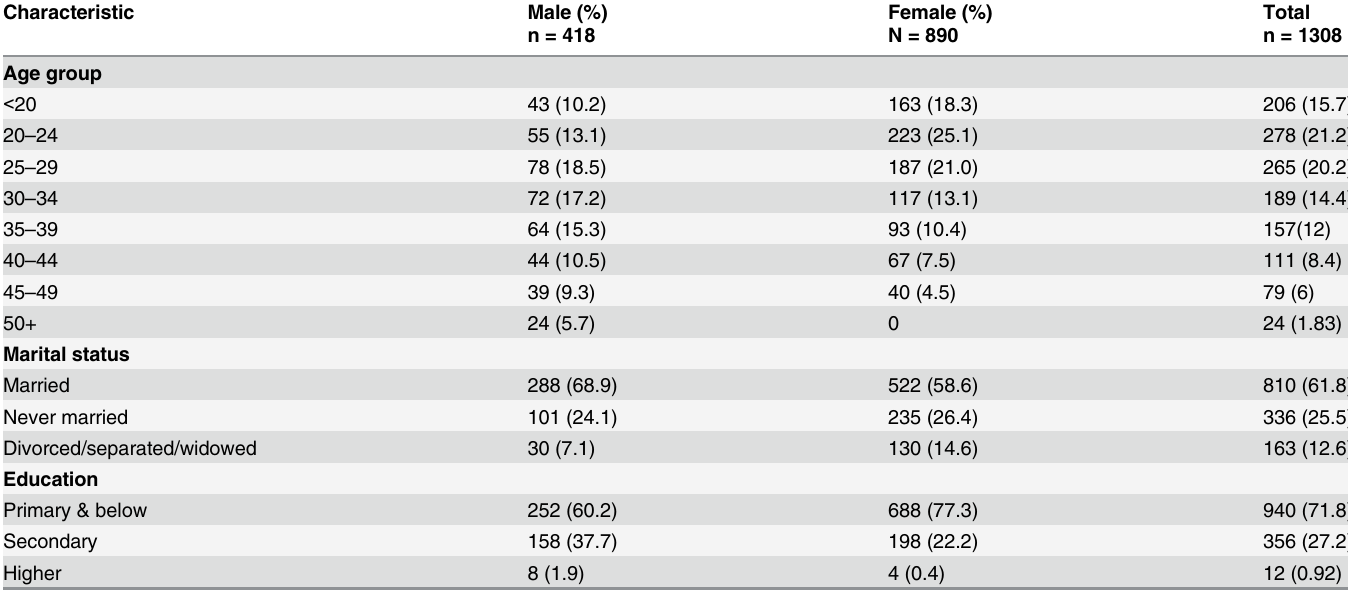
Table 1. Socio-demographic characteristics of the study population. [n = 1308] Characteristic